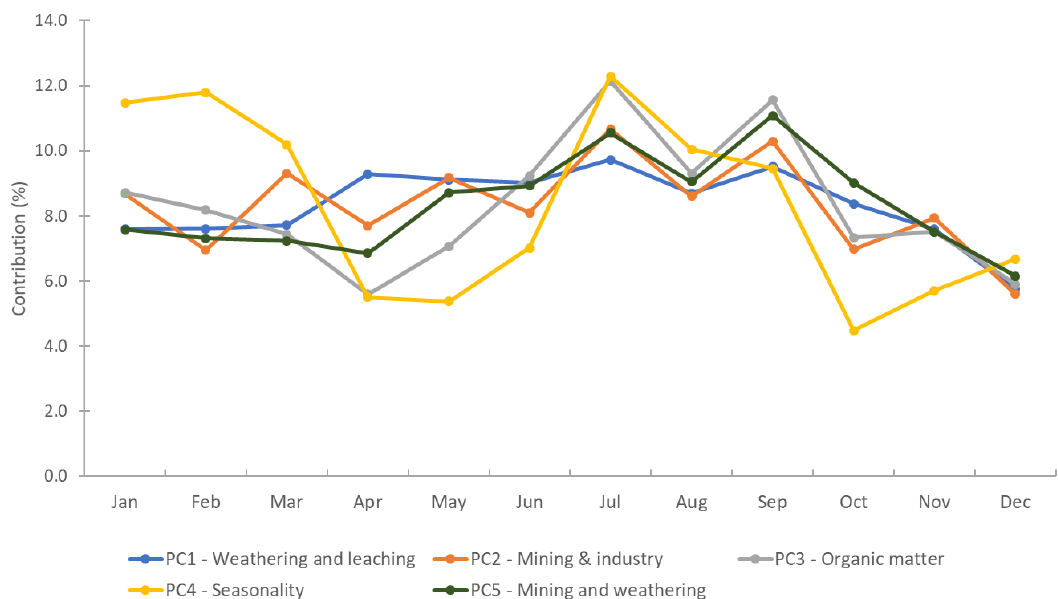
Figure 5. Temporal variation of the five major factors in explaining the data variability in Freiberger Mulde river basin over the whole monitoring period of 2006 to 2016 based on the contribution of 12 monitoring months.